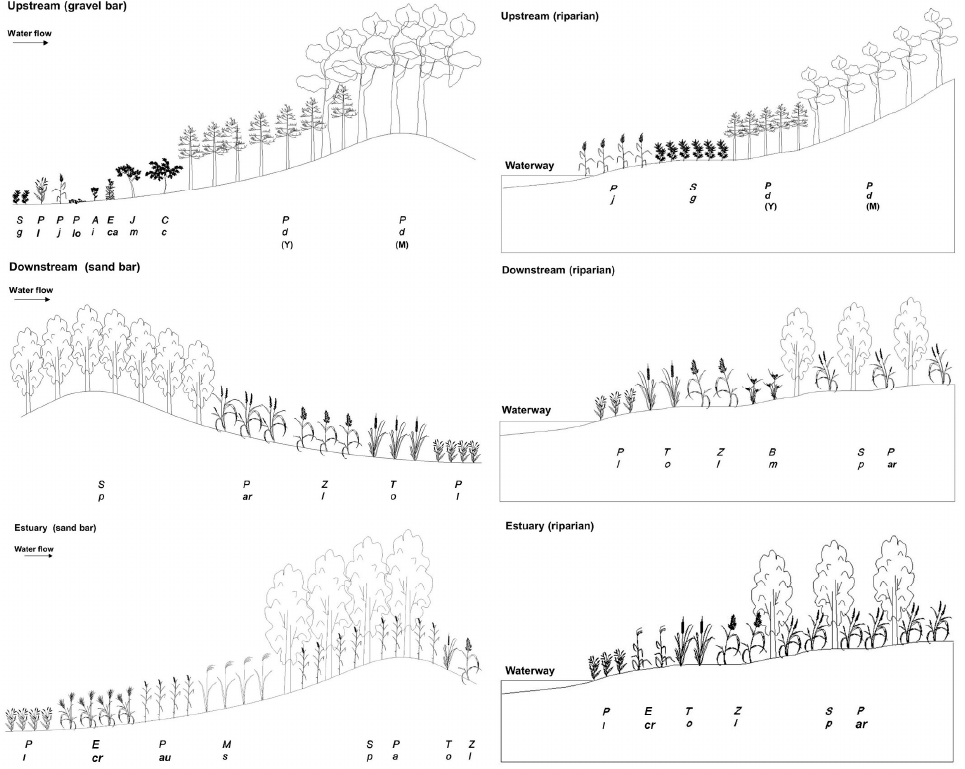
Figure 3. Stand profiles showing the horizontal distribution of riparian vegetation from the waterway to the bank ( upper ) and longitudinal distribution of vegetation established on the sand bar from upstream to downstream ( lower ) in the Jasan Stream, Goseong-gun, Gangwon-do, central eastern Korea. Ai: Artemisia indica , Bm: Bolboschoenus maritimus , Cc: Cornus controversa , Eca: Erigeron canaden- sis , Ecr: Echinochloa crus-galli var. echinatum , Jm: Juglans mandshurica , Ms: Miscanthus sacchariflorus , Par: Phalaris arundinacea , Pau: Phragmites australis Pd (M): Pinus densiflora (mature), Pd (Y): Pinus densiflora (young), Pj: Phragmites japonica , Pl: Persicaria lapathifolia , Plo: Pueraria lobata , Sg: Salix gracilistyla , Sp: Salix pierotii , To: Typha orientalis , Zl: Zizania latifolia